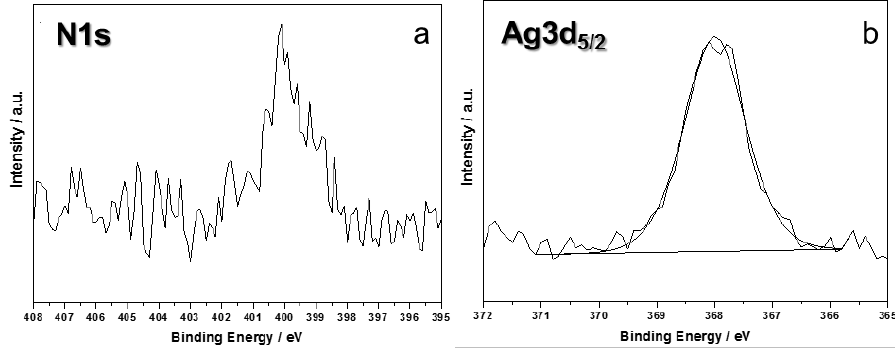
Figure 5. N1s ( a ) and Ag3d 5/2 ( b ) XP-HRR of treated leatherette.